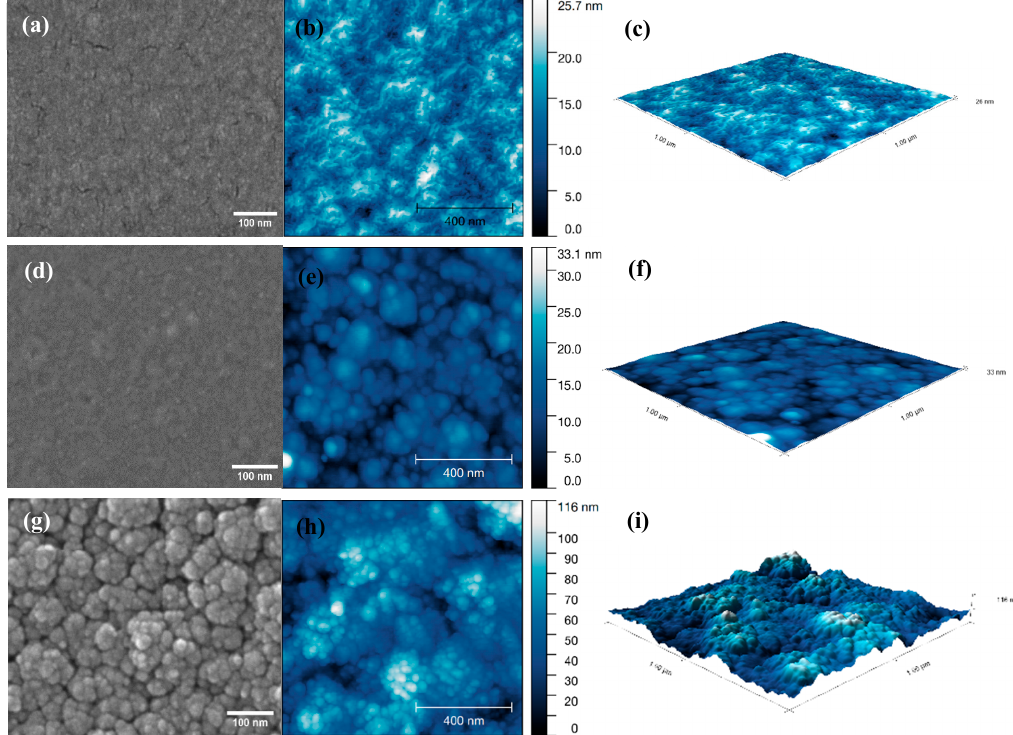
Figure 3. SEM images, AFM scans and 3D images of Al 2 O 3 films deposited for 24 h with 150 sccm Ar gas flow, precursor temperature at 120 ◦ C and deposition temperature at ( a – c ) 300 ◦ C; ( d – f ) 350 ◦